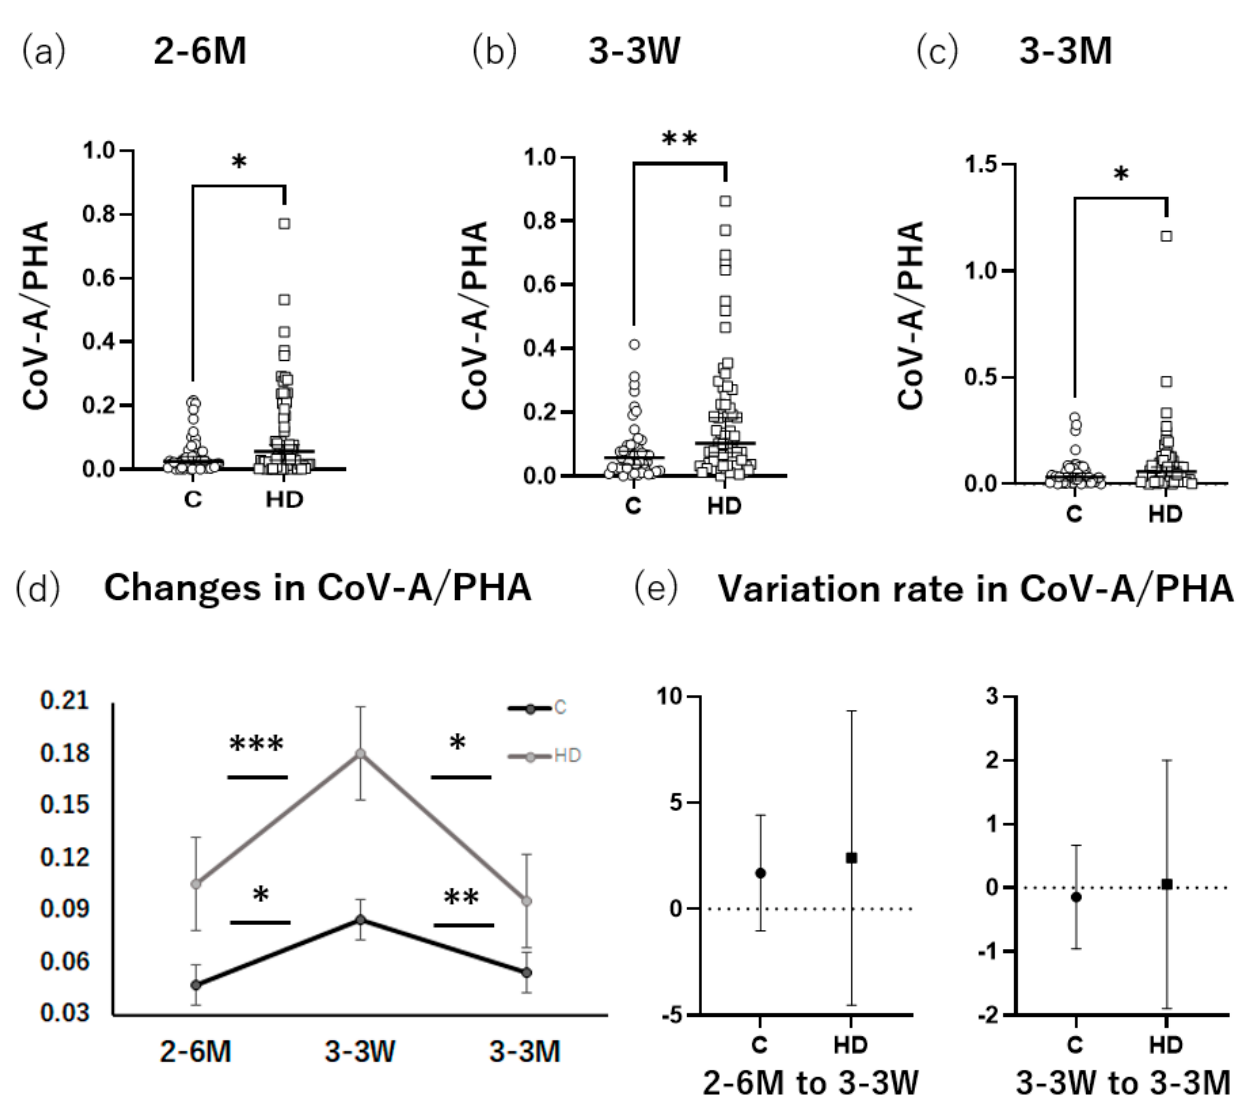
Figure 3. Changes in the T-cell response. The results of dividing the number of CoV-A spots found by the T-SPOT ® .COVID test (T-SPOT) by the numbers of spots observed in the positive control (PHA) were compared between groups (control and HD) at three time points: ( a ) 6 months after the primary series; ( b ) 3 weeks after the booster dose; and ( c ) 3 months after the booster dose. For each group, the change in the CoV-A-to-PHA ratio found using the T-SPOT is shown ( d ). The values at 3 weeks after the booster dose were significantly higher than those at 6 months after the primary series and 3 months after the booster dose for both groups. The variation rate from 6 months after the primary series to 3 weeks after the booster dose and that from 3 weeks after the booster dose to 3 months after the booster dose was compared between the control and HD groups ( e ). No significant differences were detected. 2–6 M: 6 months after the primary series; 3–3 W: 3 weeks after the booster dose; 3–3 M: 3 months after the booster dose. C: control; HD: Hemodialysis. Bars indicate the median with a 95% confidence interval. * p ≤ 0.05, ** p ≤ 0.01, *** p ≤ 0.001. PHA,